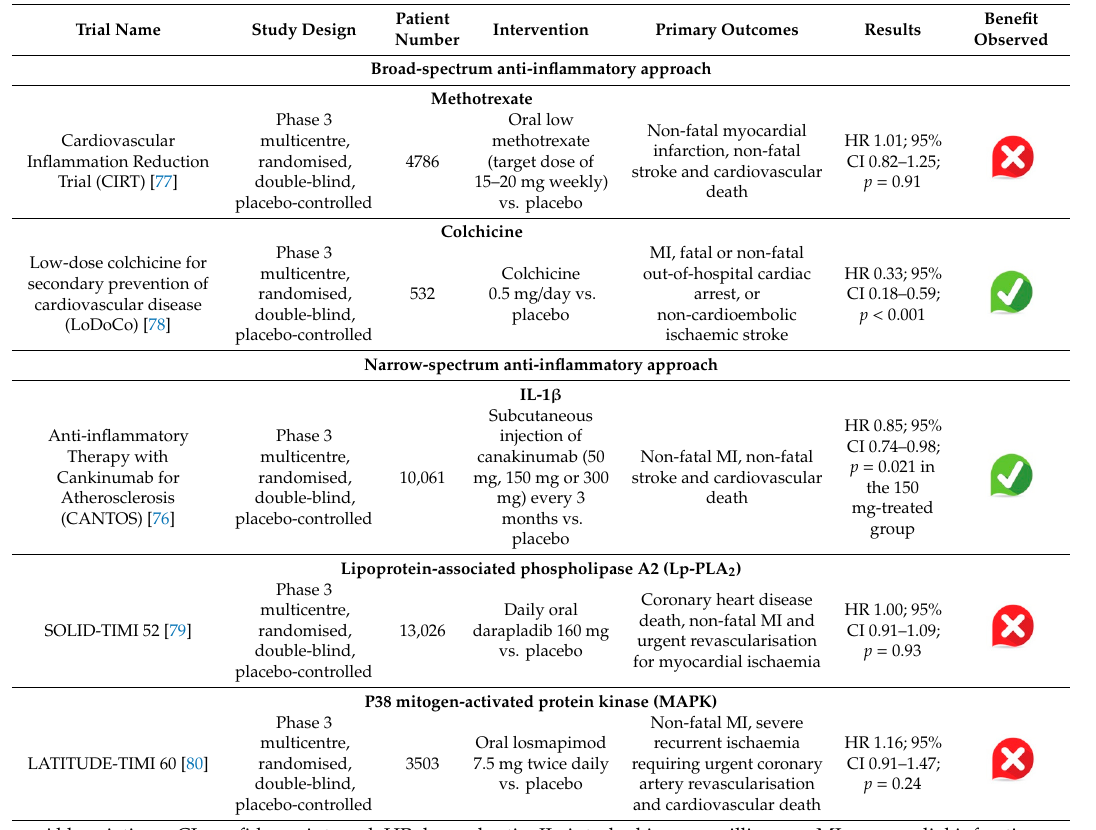
Major published clinical trials involving anti-inflammatory agents in atherosclerotic heart